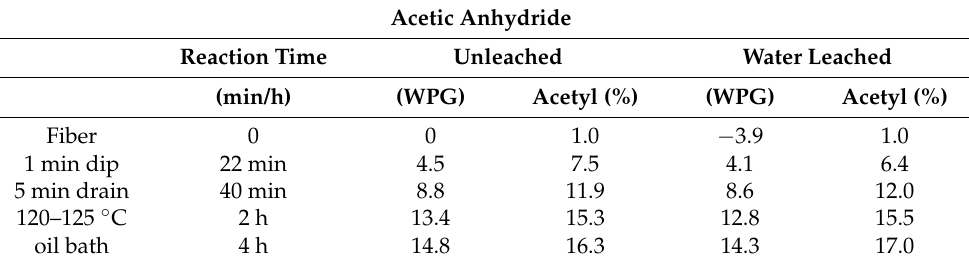
Table 3. Weight percent gain and acetyl content of AA modified wood fiber before and after water